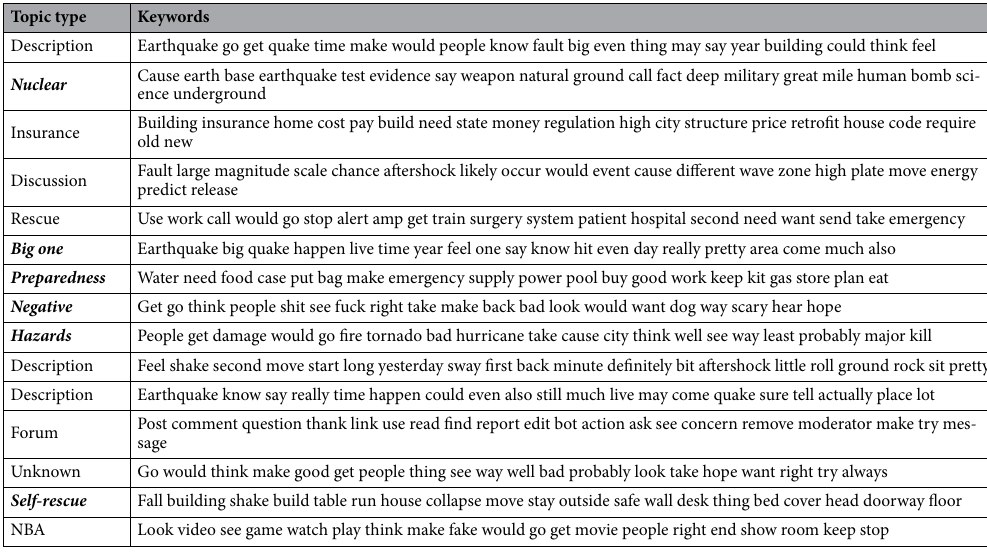
Table 2. Top 15 topics on Reddit after the M7.1 mainshock using GPU-PDMM. Topics on Twitter can be found in